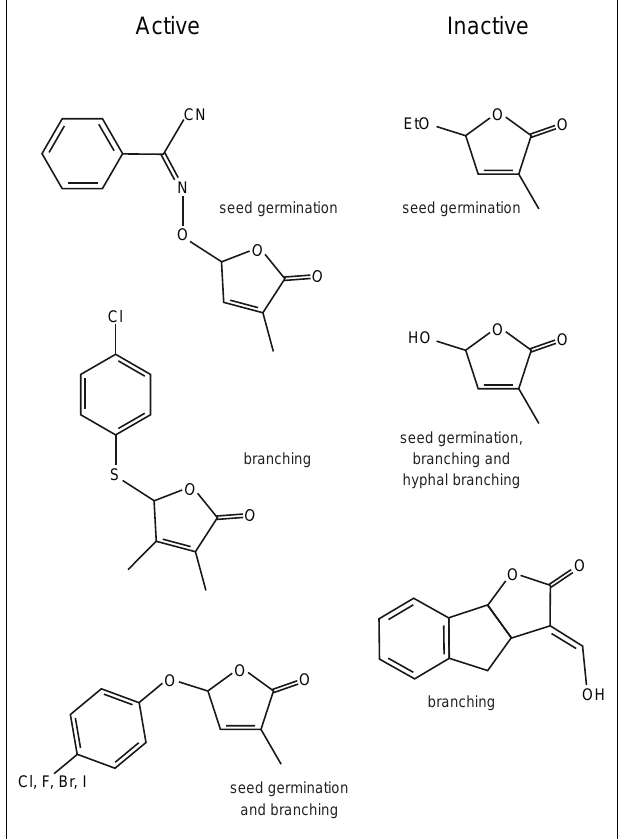
FIGURE 4 |The structures of some biologically active and inactive SL analogs and the assays used to determine activity.